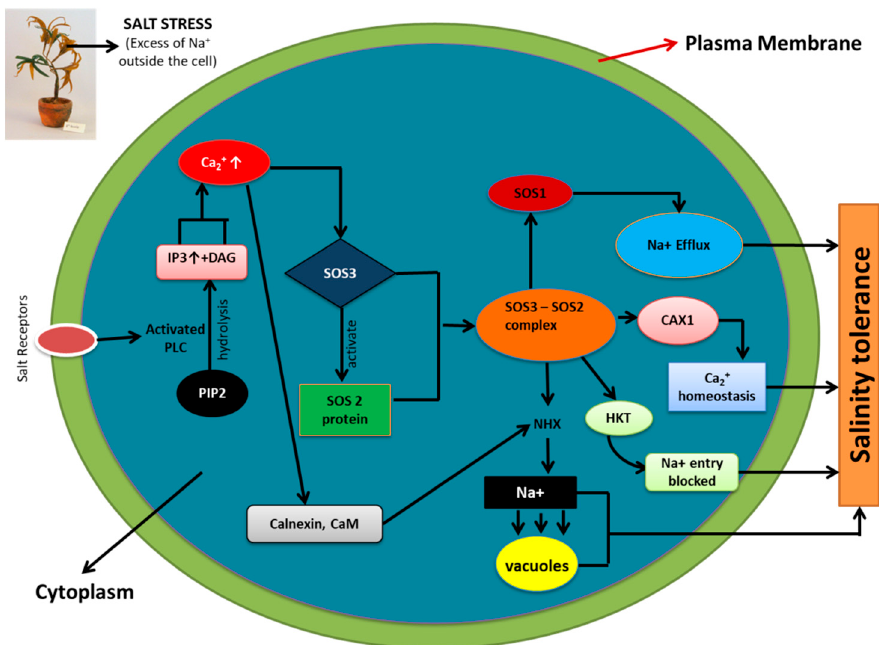
Figure 2. Salt overlay sensitive (SOS) and related pathway involved in maintenance of ion homeostasis (Na + , K + and Ca 2 + ) during salinity stress. Phosphorylation of SOS1 (Na + / H + antiporter) by SOS3-SOS2 protein kinase complex leads to Na + e ffl ux. SOS3-SOS2 complex also inhibits the activity of HKT1 (low a ffi nity Na + transporter), restricting cytosolic entry of Na + . The Vacuolar Na + / H + exchanger (NHX) is activated by SOS2 and results in Na + sequestration into vacuoles. CAX1 (H + / Ca 2 + antiporter) is involved in Ca 2 + homeostasis via SOS2 signaling. All these factors, culminatively work together to provide salinity tolerance to plants via maintaining ion homeostasis (Na + , K + , and Ca 2 + ). (Adapted from Tuteja